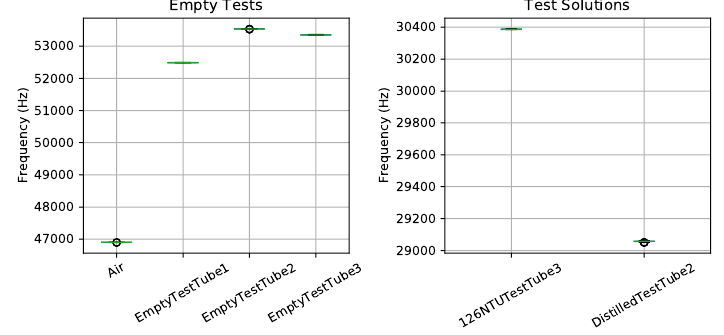
Figure 5. Light-to-frequency initial results using standard test